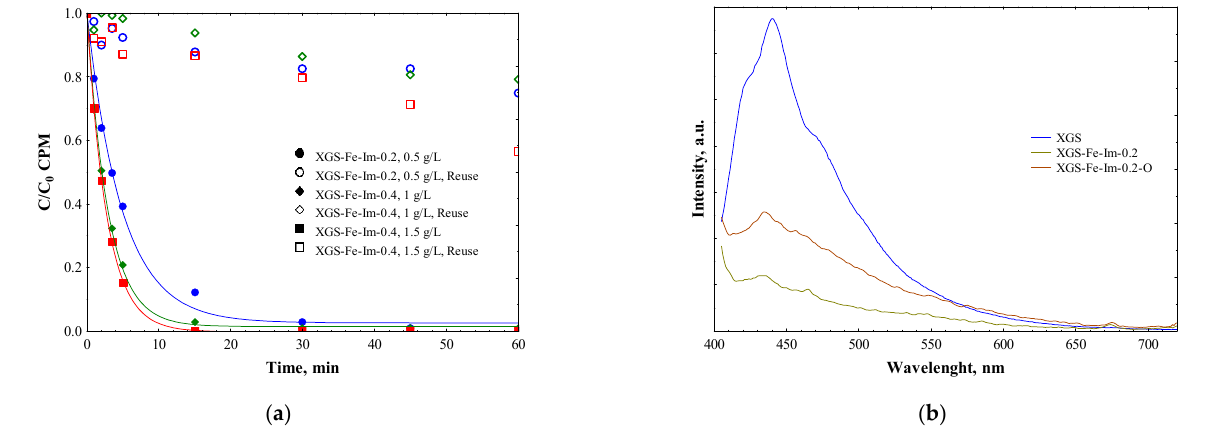
Figure 8. ( a ) CPM’s degradation curves for several reuse tests for the XGSs materials. C 0 = 15 ppm. ( b ) Photoluminescence emission spectra for XGS-Fe-Im-0.2 and the outworn material.